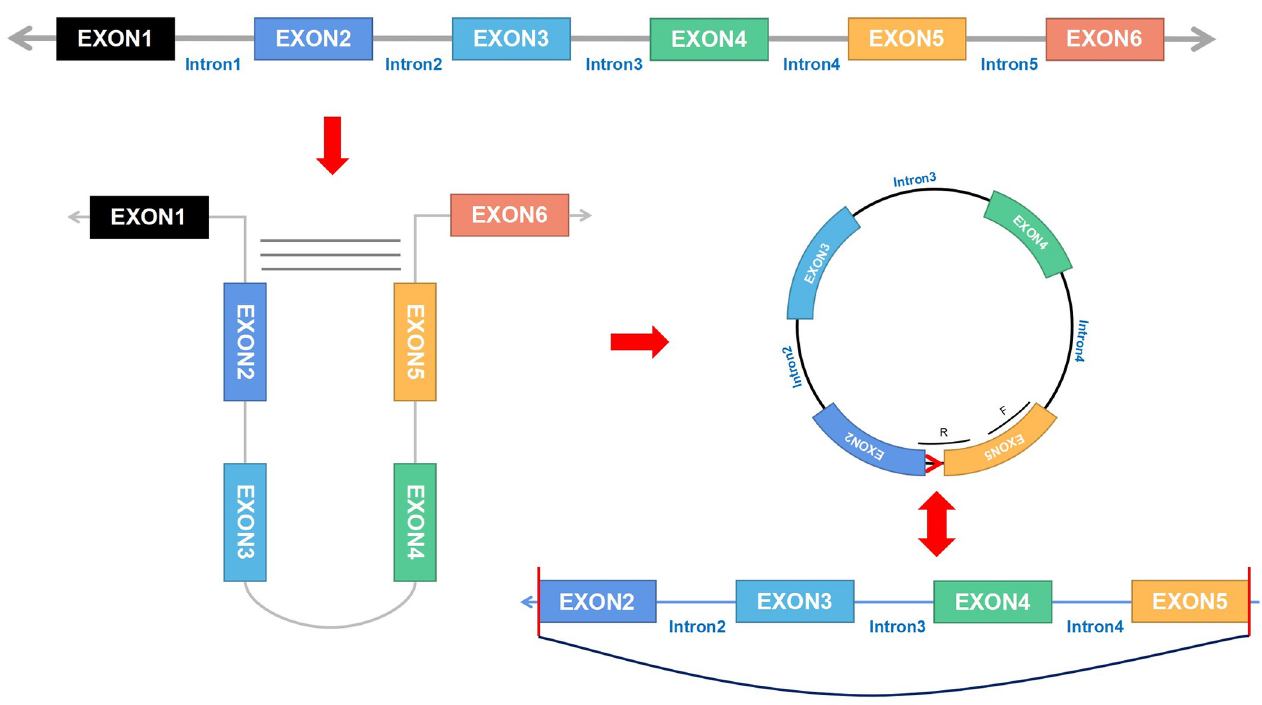
Fig 8. Schematic diagram of the transcription process of hsa_circ_0079270. During transcription, ligation is performed from before exon 2 and after exon 5 to form a circular RNA. F represents the forward primer and R represents the reverse primer.